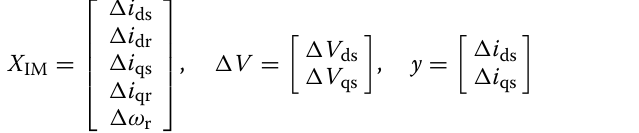
where T e is the electrical torque, T m is mechanical torque, ϕ ds , ϕ dr , ϕ qr , ϕ dr are the flux linkages for stator and rotor, i dr , i ds , i qs , i qr are the currents through stator and rotor of induction motor, X IM are the state variables of induction motor, ω b is the base angular speed, ∆ ω r is the rotor frequency, A IM is the state matrix of induction motor, B 1IM , B 2IM , C IM are the inputs for induction motor, R s and R r are stator and rotor resistances, respec- tively, X s is stator leakage reactance and X m is the magnetizing reactance and (cid:31) V is volt- ages of the induction motor with DQ reference